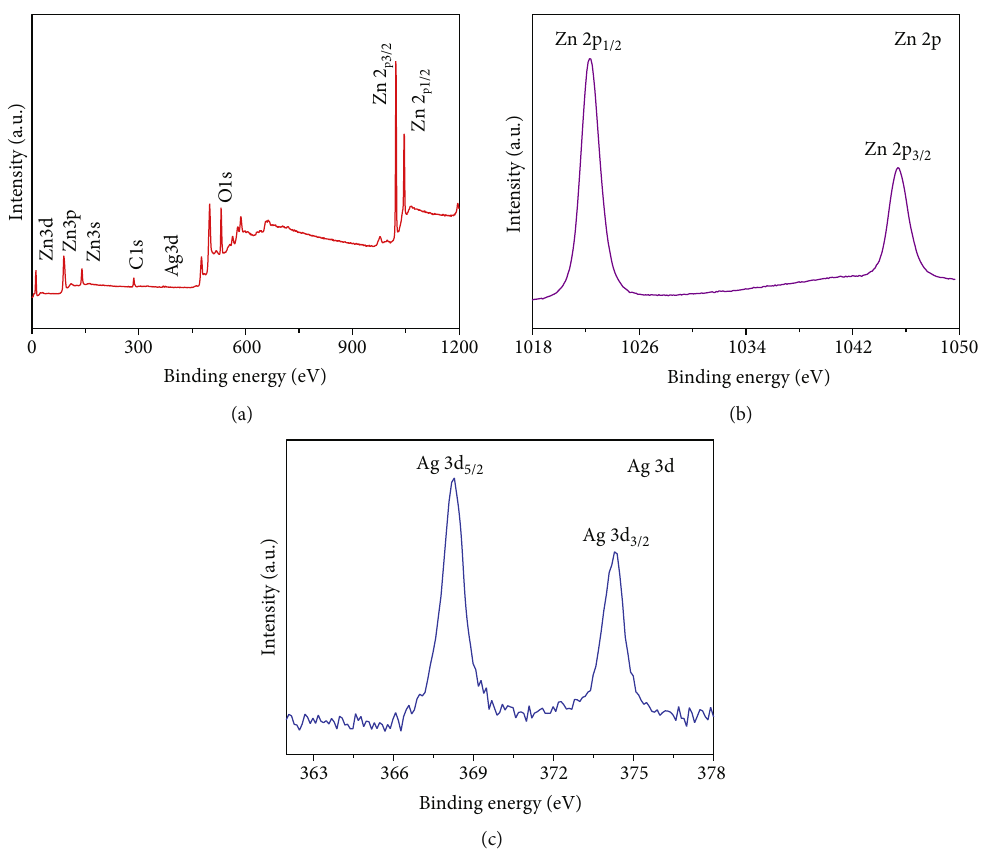
Figure 5: (a) XPS survey of the 3 at% Ag-functionalized porous ZnO sheets and high-resolution XPS core-levels of (b) Zn 2p and (c) Ag 3d.